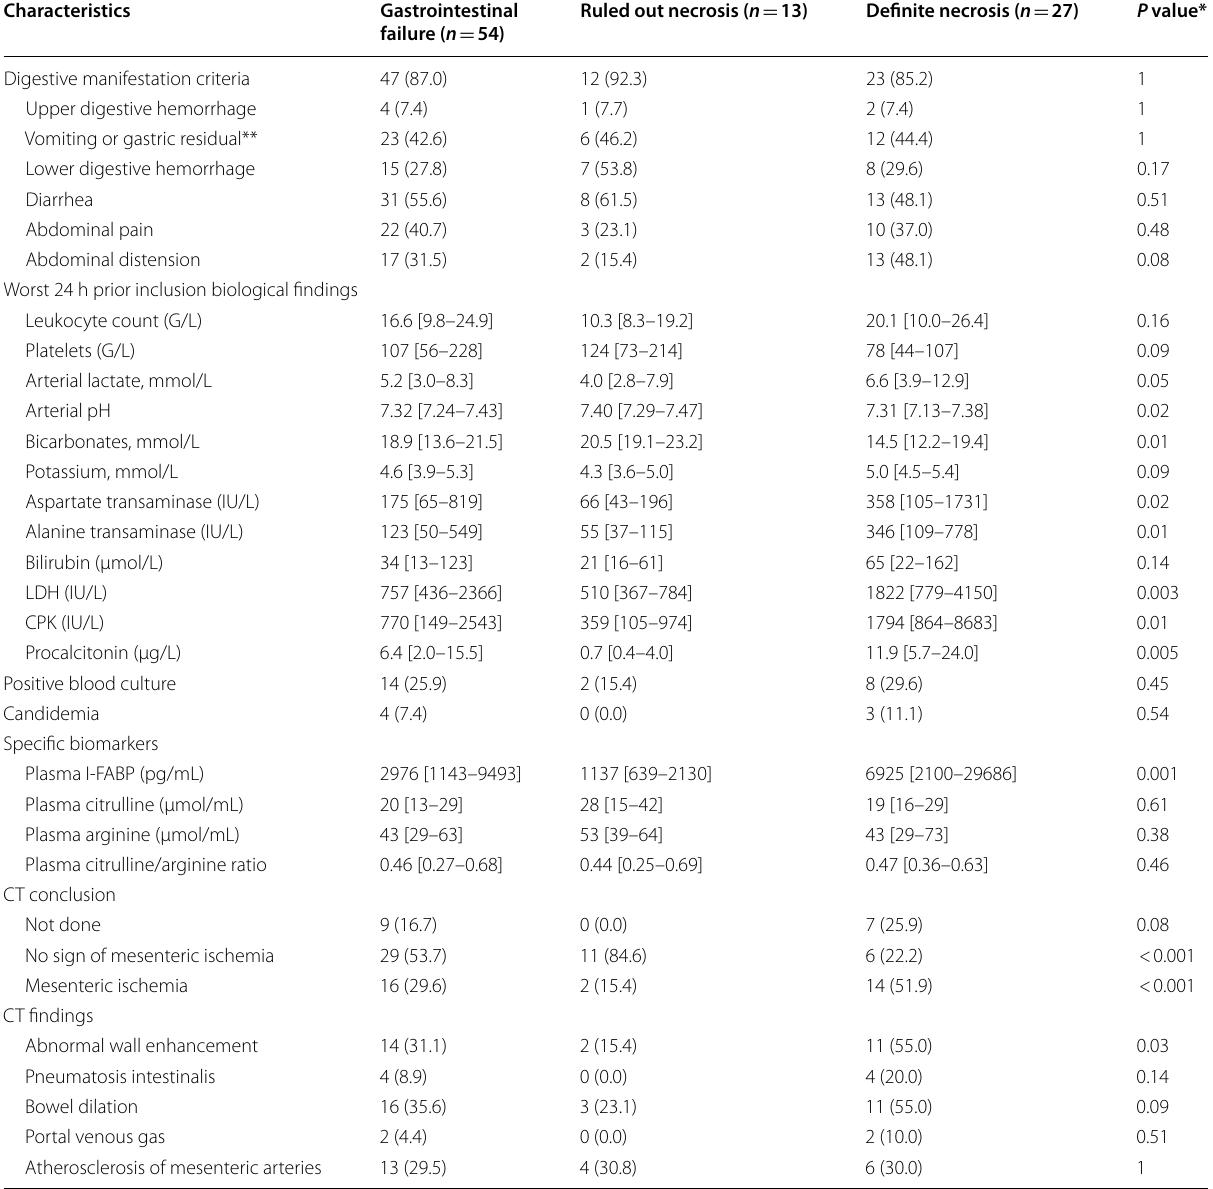
Table 1 Digestive, biological parameters and CT results among patients with defined and ruled out intestinal